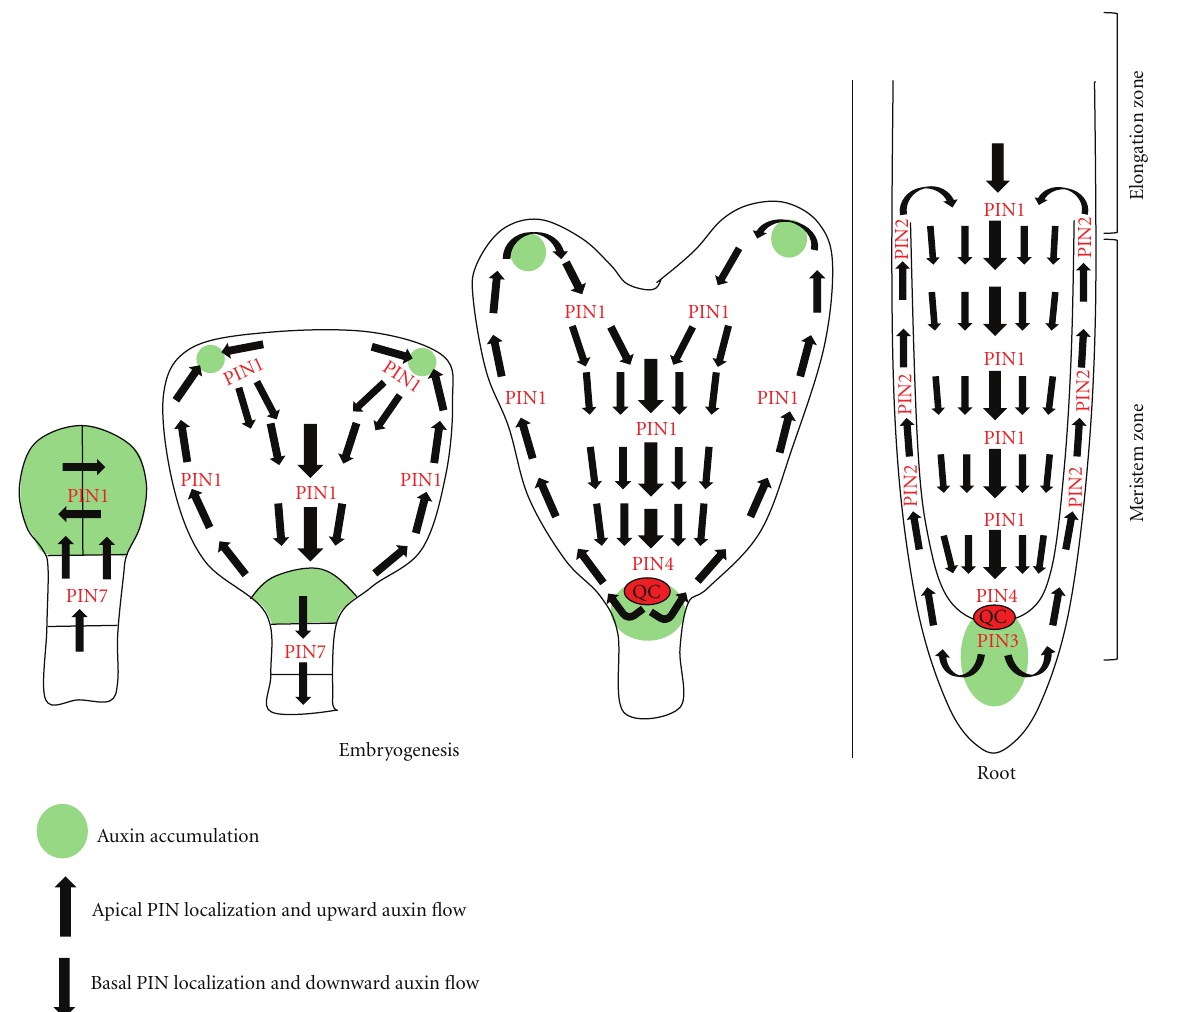
Figure 1: Polar-localized auxin e ffl ux carrier PIN proteins direct auxin flow. Note that apical PINs guide upward auxin flow and the basal PINs guide downward auxin flow. Generation of directional auxin flux creates auxin accumulation zones that are required for proper progression of embryogenesis and for postembryonic organ functioning such as the root